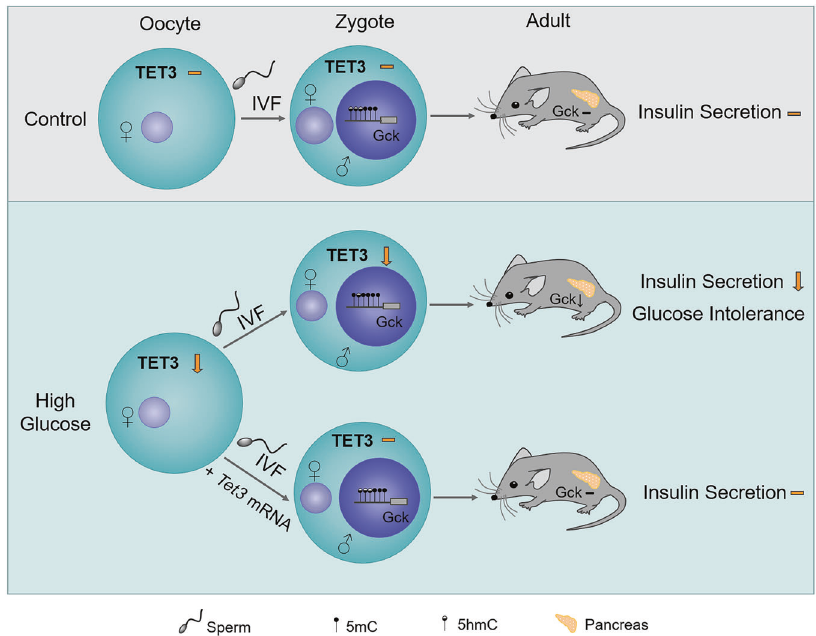
Fig. 1 Oocyte TET3 mediates maternal inheritance of glucose intolerance. The mature sperm genome undergoes active demethylation after fertilization. Oocyte TET3 is responsible for demethylation of the paternal genome by catalyzing the conversion of 5mC into 5hmC and other high-oxidation products. In fertilized oocytes from healthy mice, TET3 demethylates the promoter of several genes involved in insulin secretion such as Gck , leading to normal expression of these genes and insulin secretion in the pancreas at the adult stage. In contrast, Tet3 mRNA is reduced in oocytes from hyperglycemic mice, resulting in hypermethylation of the paternal-derived Gck promoter. This leads to decreased Gck expression and lower levels of insulin secretion in the pancreatic islets of the offspring in adulthood. Furthermore, injection